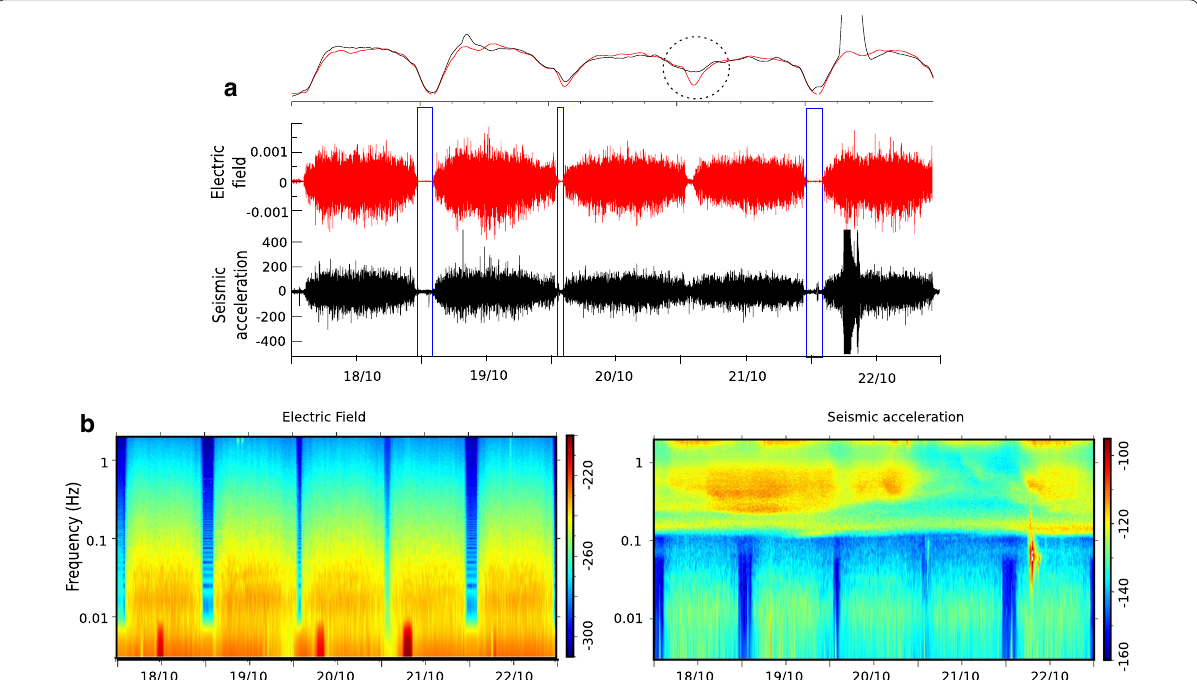
Fig. 8 Collocated electric and seismic signals related to subway and tramway activity. a Electric field (V/m, red line) and seismic vertical acceleration (nm/s 2 , black line) filtered between 0.005 and 0.05 Hz recorded between October 18 and 23, 2018. Intervals without subway activity are marked with blue boxes. The upper panel shows the envelope of the same signals, downsampled to one sample every 20 min. Dotted circle highlights the difference between electric field and seismic data during the Saturday to Sunday night (see text). b Spectrograms of the seismic acceleration (right) and electric field (left) expressed in